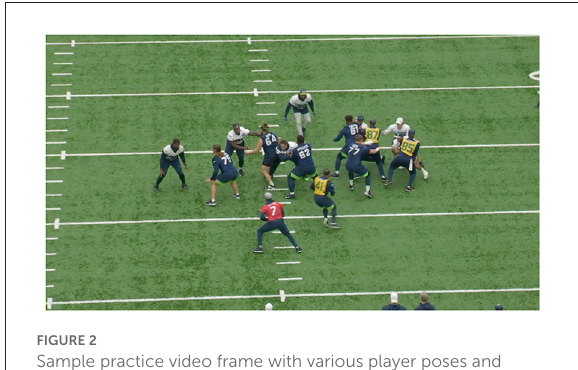
FIGURE2 Sample practice video frame with various player poses and